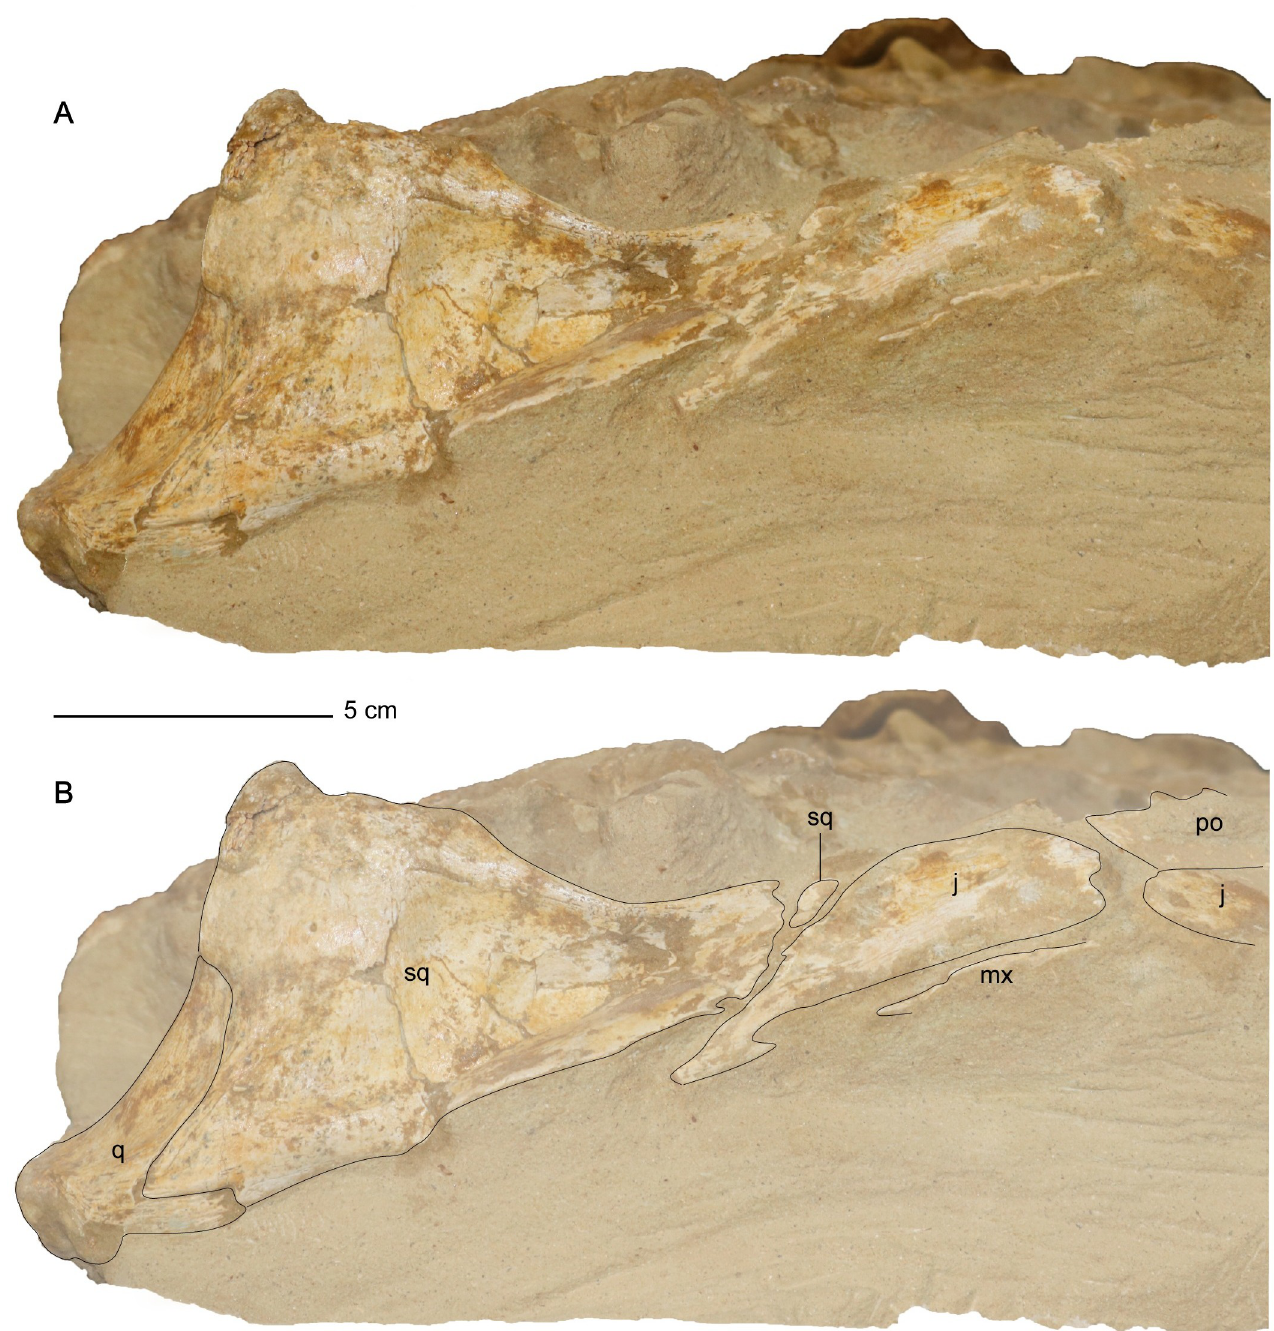
Fig 10. Cardiocorax mukulu (MGUAN PA278) with exposed right temporal bar. A. Right temporal bar. B. Borders of elements in right temporal bar labeled. https://doi.org/10.1371/journal.pone.0255773.g010 jugal dorsally and extends posteriorly along the dorsal margin of the temporal bar where it contacts the anterior ramus of the squamosal. The postorbital terminates before the mid-point of the temporal fenestra (Fig 5). The postorbital would have contributed to a substantial por- tion of the posterior margin of the orbit (Fig 5). This condition is similar to Libonectes morgani